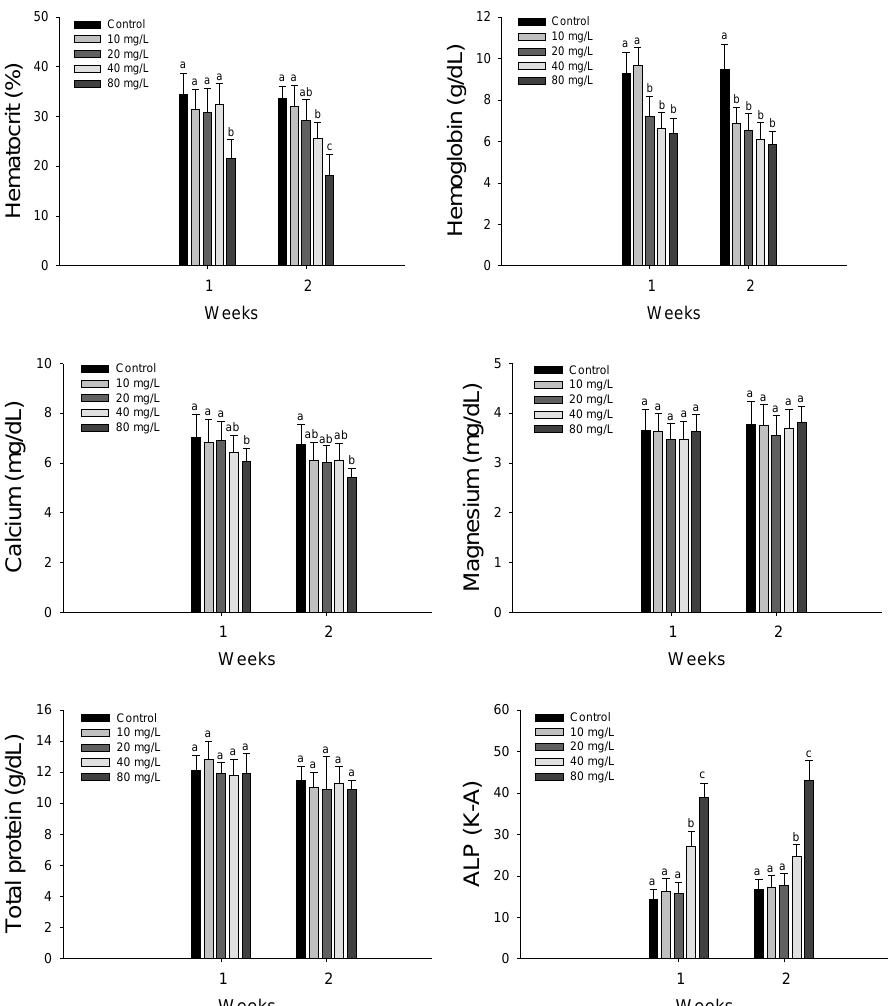
Figure 1. Changes of blood physiology in hybrid groupers, Epinephelus lanceolatus ♂ × Epinephelus fuscoguttatus ♀ exposed to waterborne nitrite for 2 weeks. Vertical bar denotes a standard error. Values with different superscript are significantly different ( p < 0.05) as determined by the Tukey’s multiple range test.